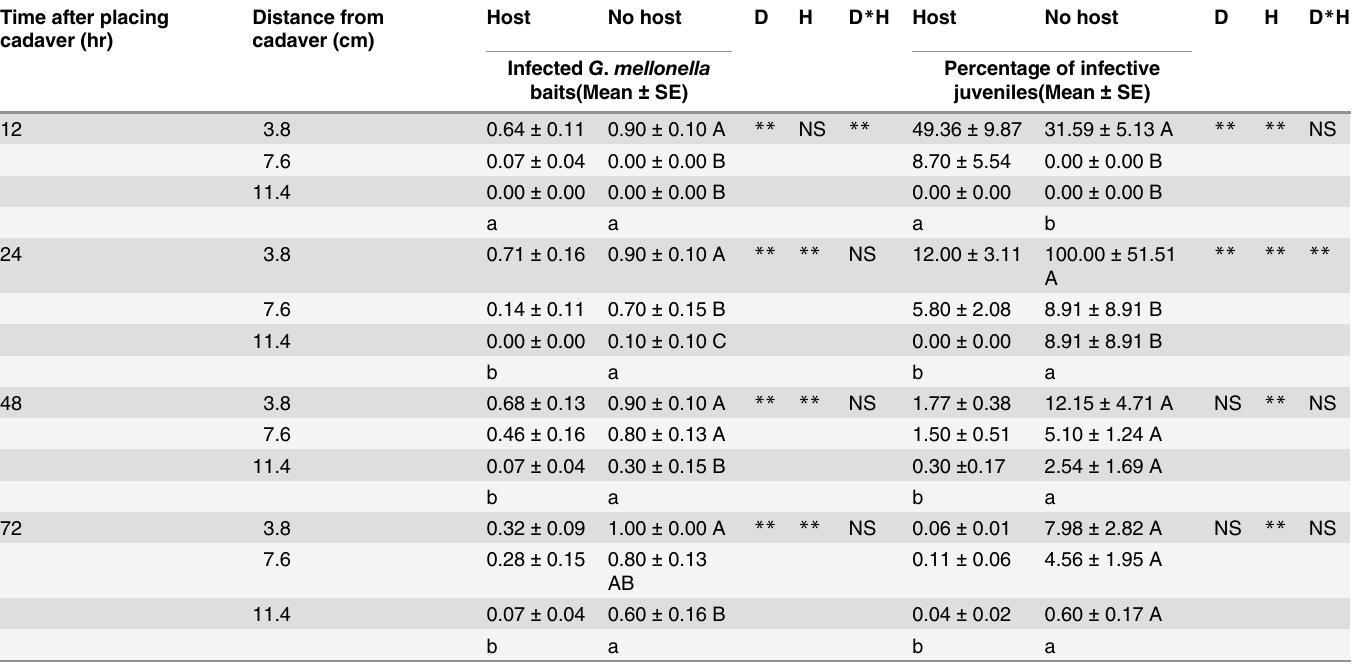
Mean ( ± SE) number of infected Galleria mellonella baits from the collected soil core samples and mean ( ± SE) percentage of infective juveniles (IJs) of Heterorhabditis bacteriophora dispersed to a 2 cm wide annulus at distances, 3.8, 7.6 and 11.4 cm over a period of 12 to 72 hr in the presence of 2 mobile hosts, G . mellonella larvae placed outside the wire mesh cylinder (3.8 cm dia) enclosing the source cadaver in the microcosms containing autoclaved fi eld soil with vegetation as opposed to similar microcosms containing no hosts. Double asterisk ( ** ) indicates signi fi cant difference between distances (D), presence or absence of the host (H) and interaction between the two (D * H) at a time point at P (cid:1) 0.05. Capital and small letters indicate Tukey ’ s comparison for means separation between distances averaged over presence or absence of the host, and presence and absence of host averaged over distances, respectively at a time point. NS = P >